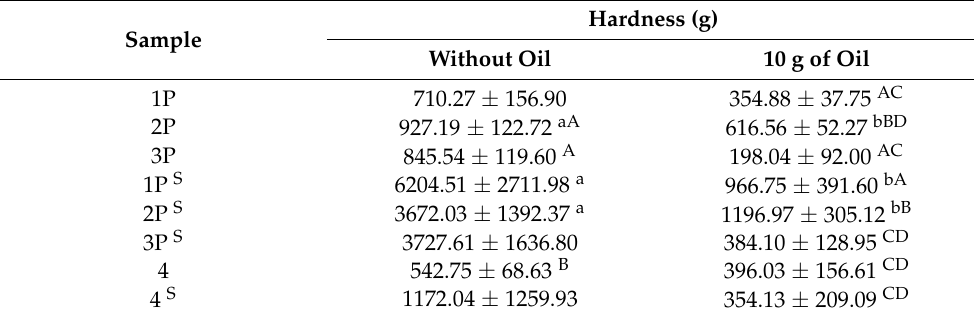
Table 5. The influence of palm oil addition on the hardness of biodegradable spoons made of millet flour.